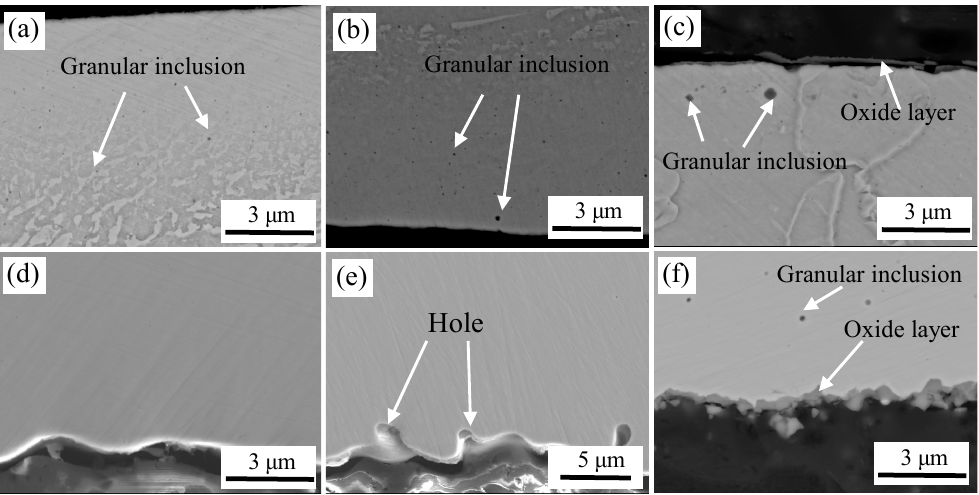
Figure 11. The cross-sectional images of high temperature oxidation at different degrees of vacuum. At 10 –2 Pa: ( a ) carbon steel and ( d ) stainless steel; at 1 Pa: ( b ) carbon steel and ( e ) stainless steel; and at 10 5 Pa: ( c ) carbon steel and ( f ) stainless steel.